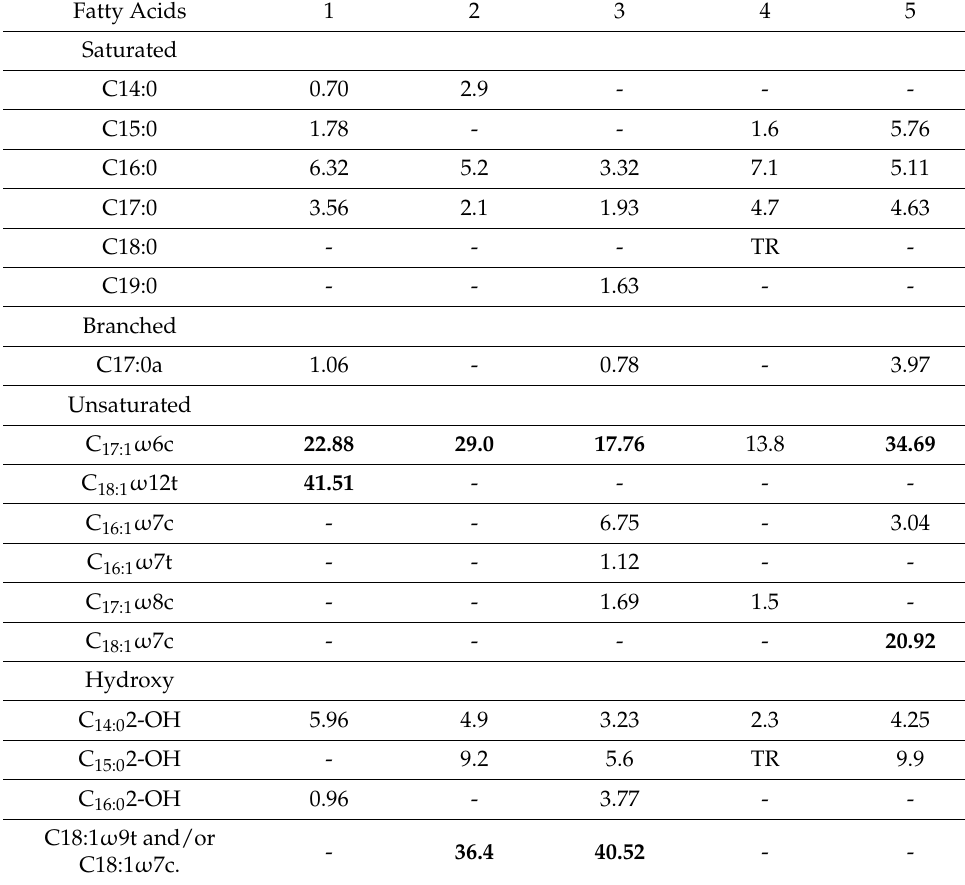
Table 1. Fatty acid profiles of ( 1 ) NZ-12B T and the phylogenetically closest relatives; ( 2 ) A. lutimaris S-5 T (data from [6]); ( 3 ) Q. citreus RE35F/1 T ; ( 4 ) A. halimionae CPA5 T (data from [41]); and ( 5 ) Q. pelagi UST081027-248 T . Values are percentages of the total fatty acids. The bold type represents the major fatty acids. —, Not detected. TR, Trace amount